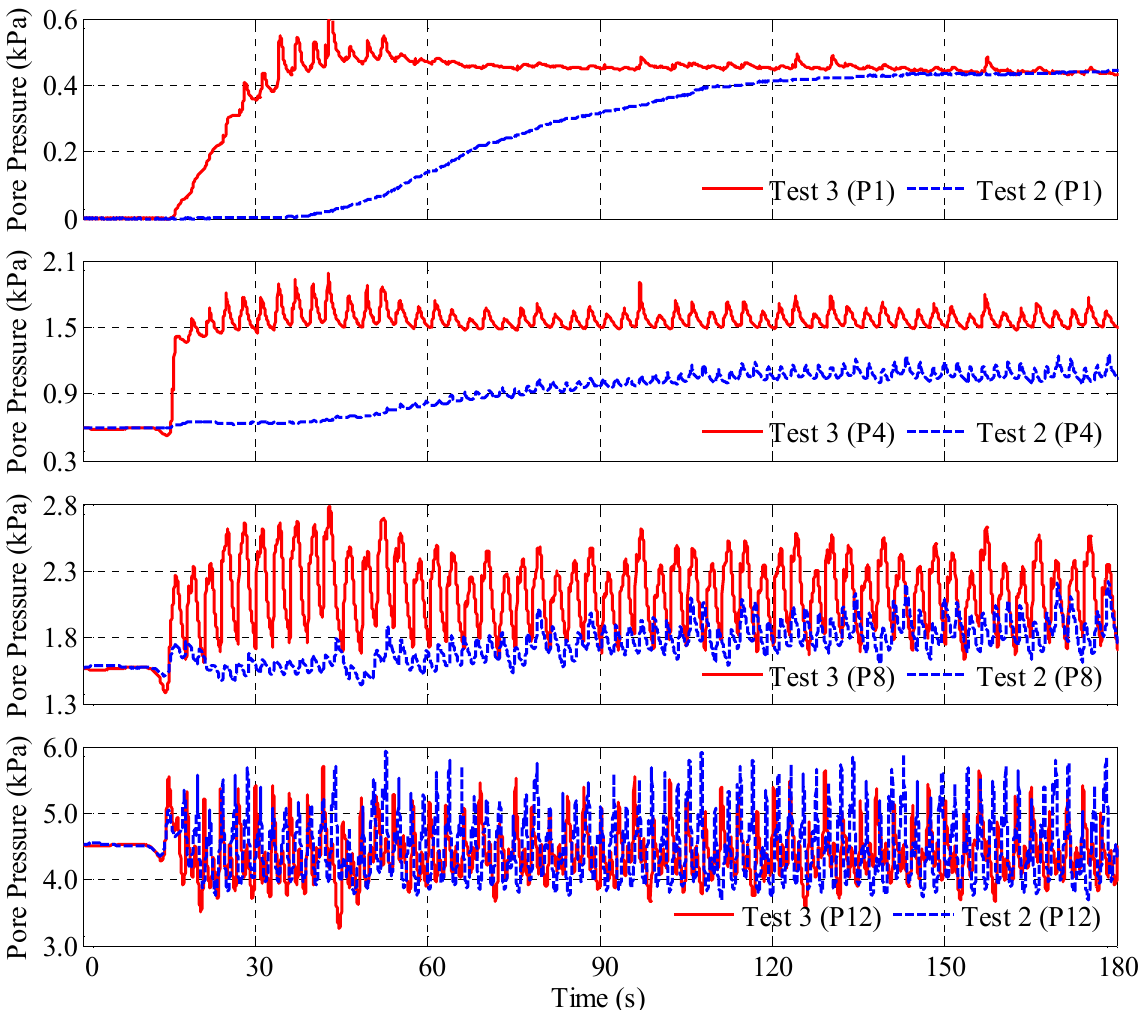
Figure 19. Comparison of pore pressure recorded at P1, P4, P8 and P12 between Test 3 ( T = 3.0 s) and Test 2 ( T = 2.2 s).